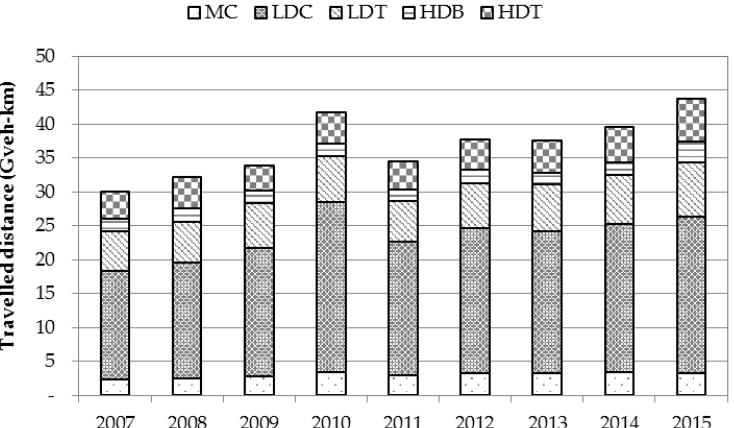
Figure 7. Distance traveled on highway roads in the BMR area from 2007–2015. Remark: MC stands for motorcycle; LDC stands for light duty car (including passenger cars less than seven seats and passenger cars over seven seats); LDT stands for light duty truck; HDB stands for heavy duty bus (including mini-buses, medium-buses, coaches); and HDT stands for heavy duty truck (including semi-trucks, trucks, semi-trailers, and